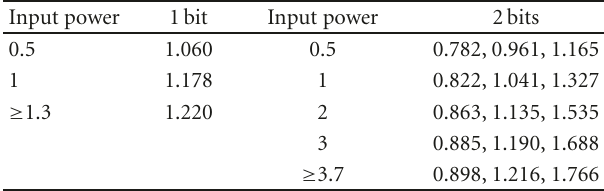
Table 2: Optimal quantization boundaries, reliable quantization region detection, long-term power constraint, and CG distribution: Nakagami, μ = 3, w = 1.